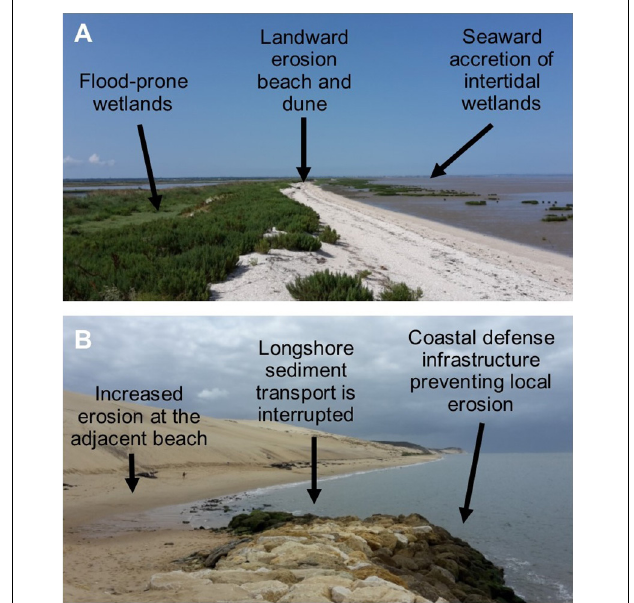
FIGURE 9 | Examples of sites that could benefit from improvments of data models of coastal databases; (A) example of coastal wetland experiencing both a chronic retreat of the sand dune and vertical accretion of muddy landforms (Marais d’Yves, Atlantic Coast of France, Site owned by the Conservatoire du Littoral); (B) example of transition beween protected and non-protected shorelines (Dune du Pila, South-Western Aquitaine Coast).